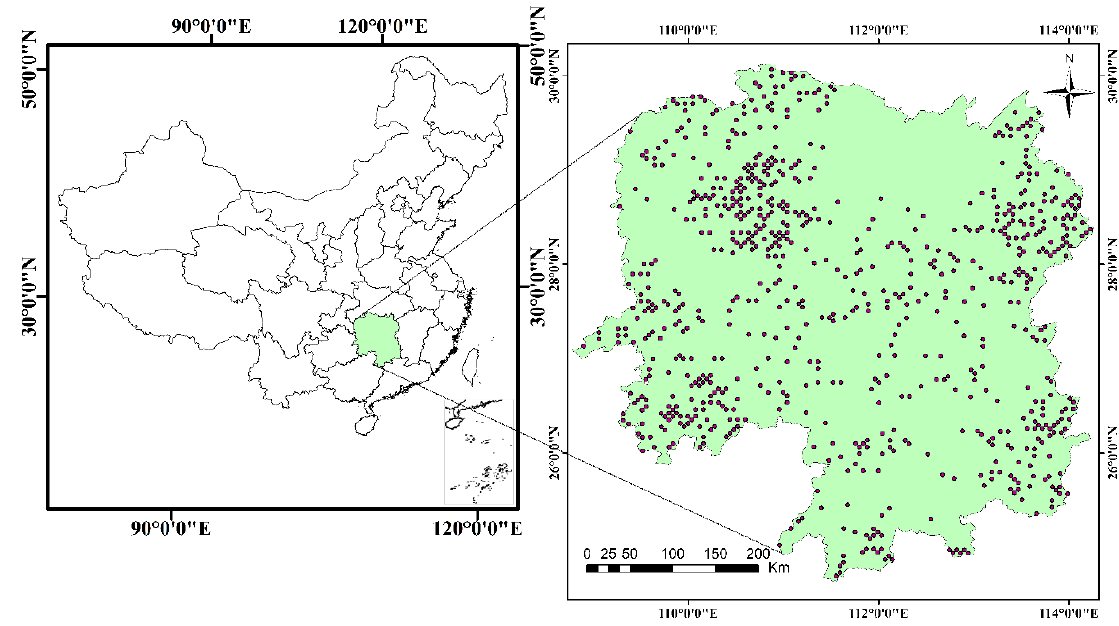
Figure 1. Distribution of the inventory sample plots for oaks in the studied area.